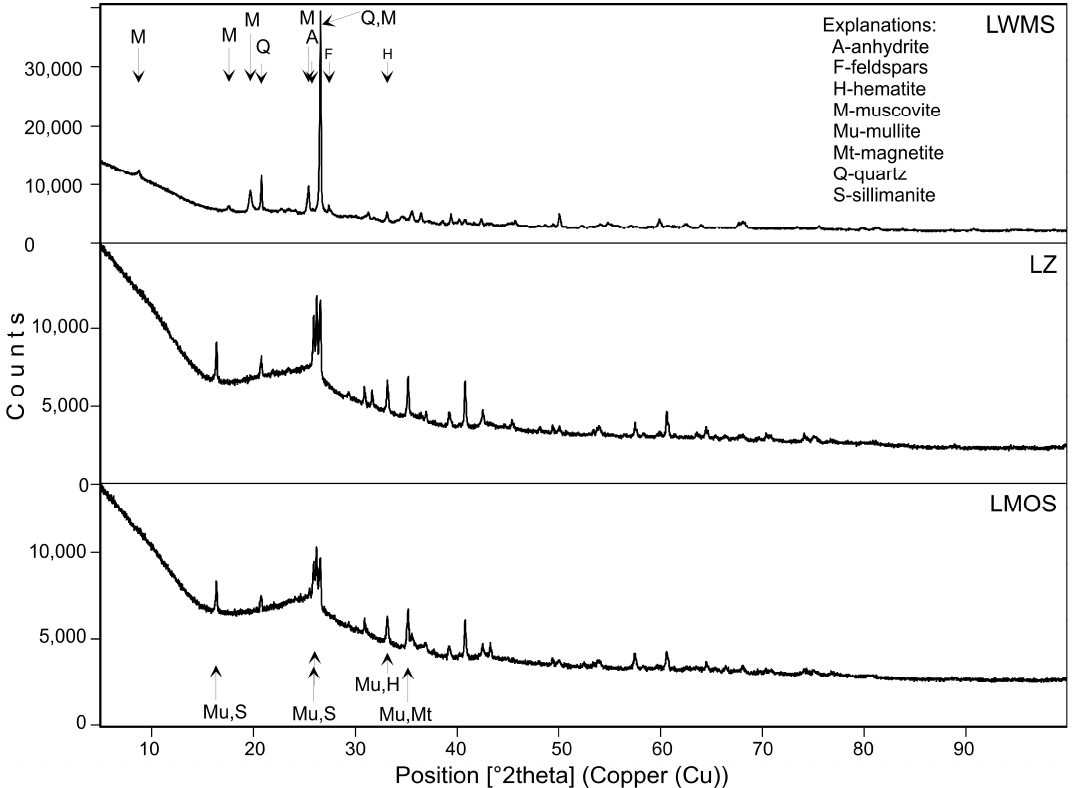
Figure 1. X-ray diffraction pattern of samples (the arrows indicate the basic phase reflexes).